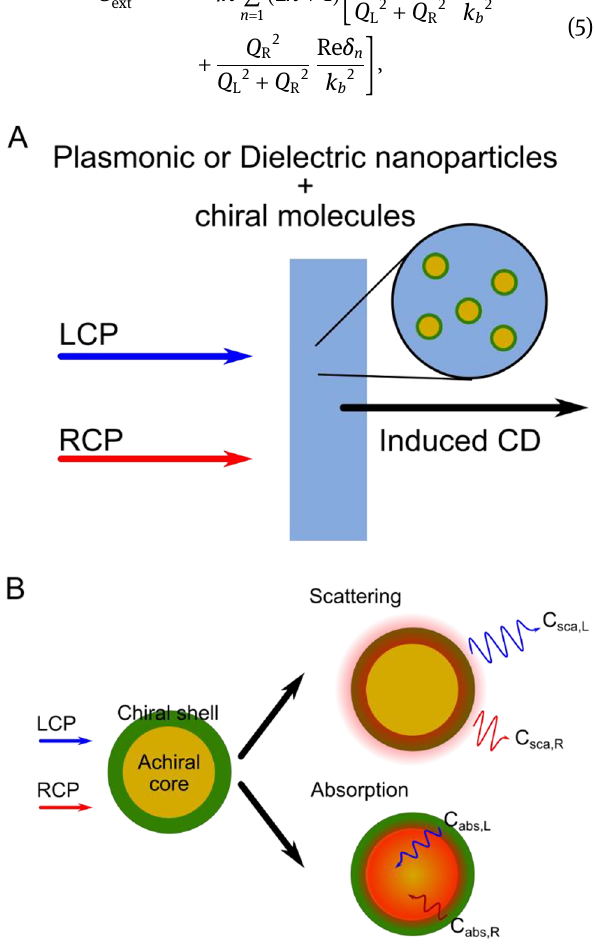
Figure 1: Schematic figure of CD measurement for (A) achiral plasmonic and dielectric nanoparticles capped with chiral molecules (B) schematic fi gure of Chiral Mie theory for large-sized achiral core-chiral shell nanospheres embedded in achiral